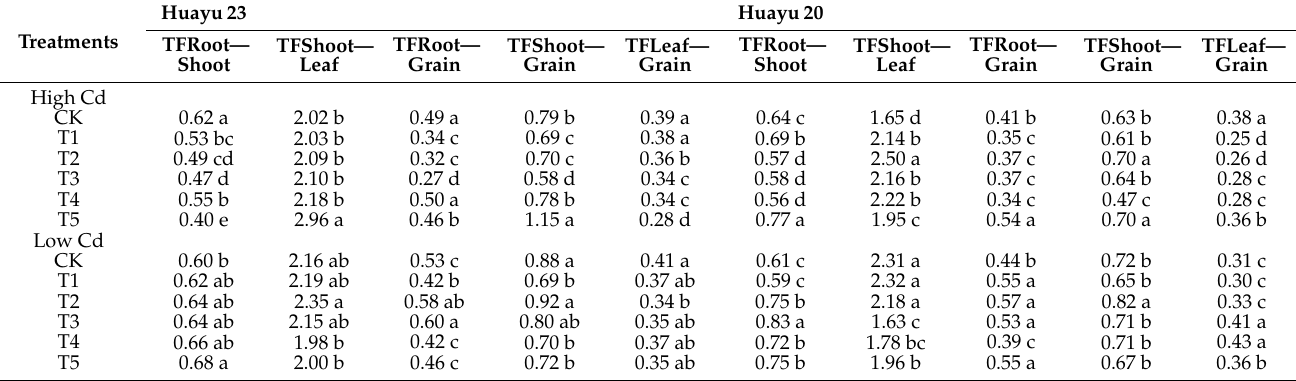
Table 4. Cadmium transport coefficients of Huayu 23 and Huayu 20 from roots to stems, stems to leaves, and leaves to grains under different treatments.